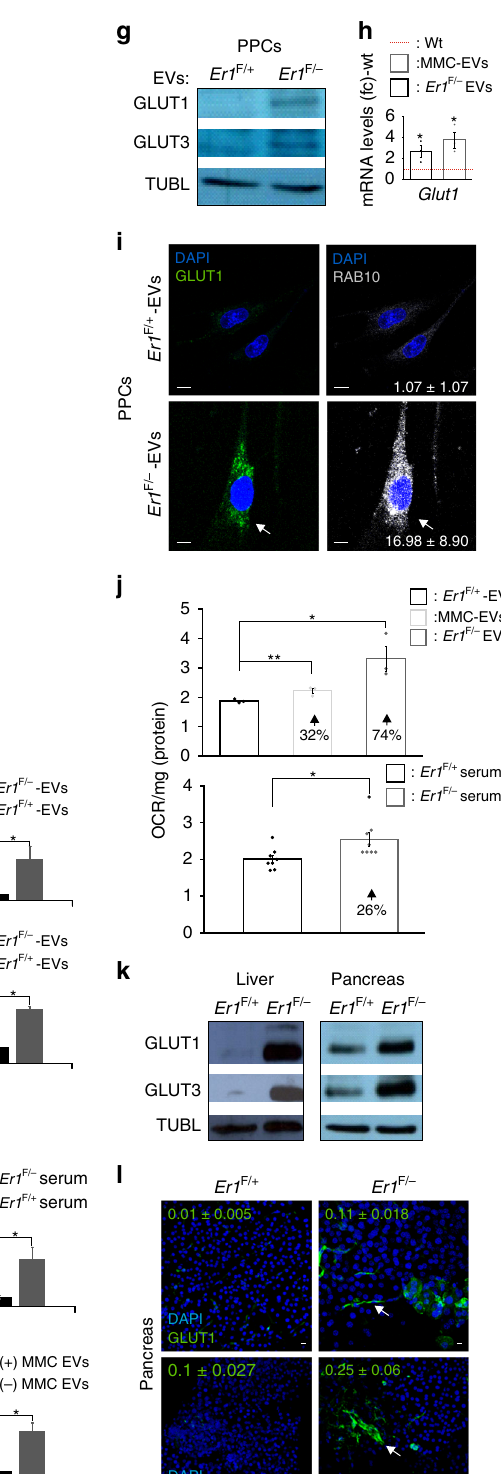
and were injected intraperitoneally with 0.75 Units/kg of body weight insulin (Humulin, Ely Lili). For glucose tolerance tests (GTT), mice were fasted for 16h. and subsequently were injected intraperitoneally with 1mg/gr of body weight 35% dextrose solution. Blood glucose levels were measured using CONTOUR ® meter, at the indicated time points. To determine steady state glucose levels, 4- and 6- months-old animals were fasted for 2h and glucose was determined. Serum insulin and triglyceride levels were measured with specialized kits (ALPCO and LabAssay triglyceride, Wako Chemicals, respectively). Mice were maintained in grouped cages in a temperature-controlled virus-free facility on a 12-h light/dark cycle and